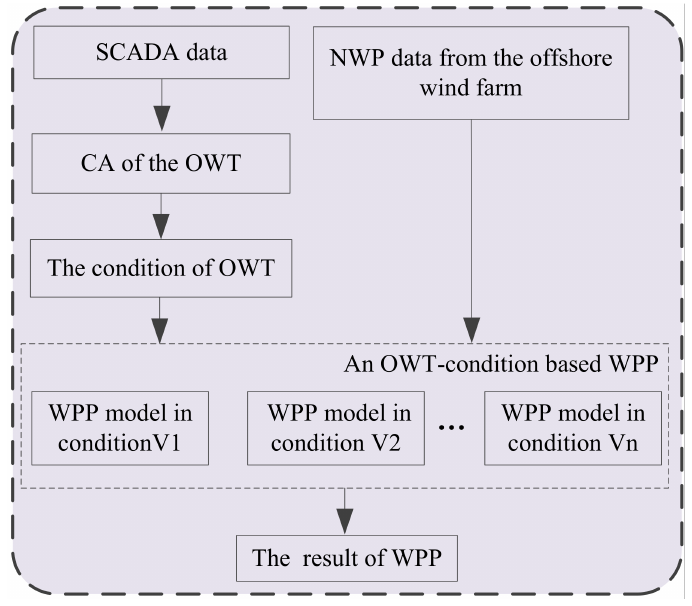
Figure 1. Framework of offshore WPP.